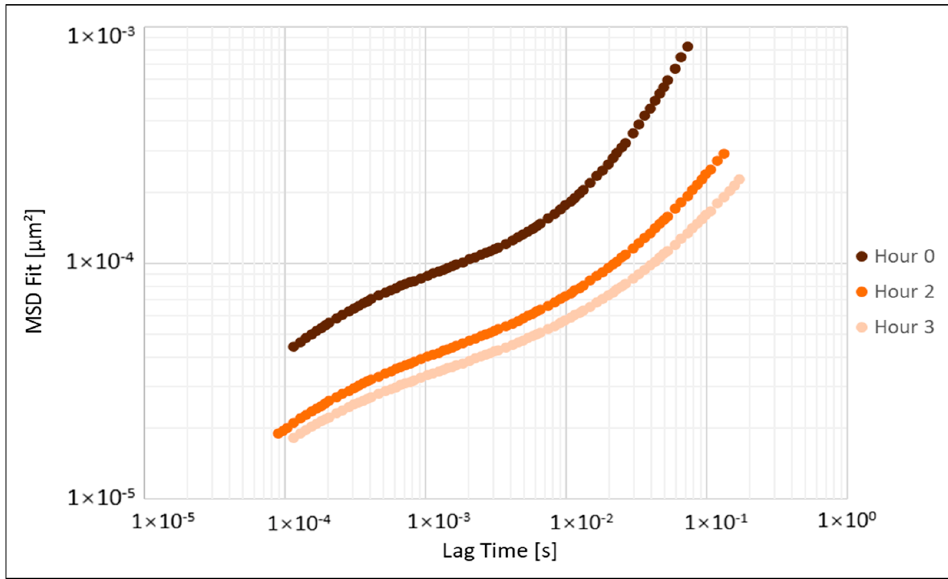
Figure 3. 3.25 wt % CAPB, 3.25 wt % SLES, 15 wt % jojoba oil emulsion variation in MSD values over a 3 ‐ h period.